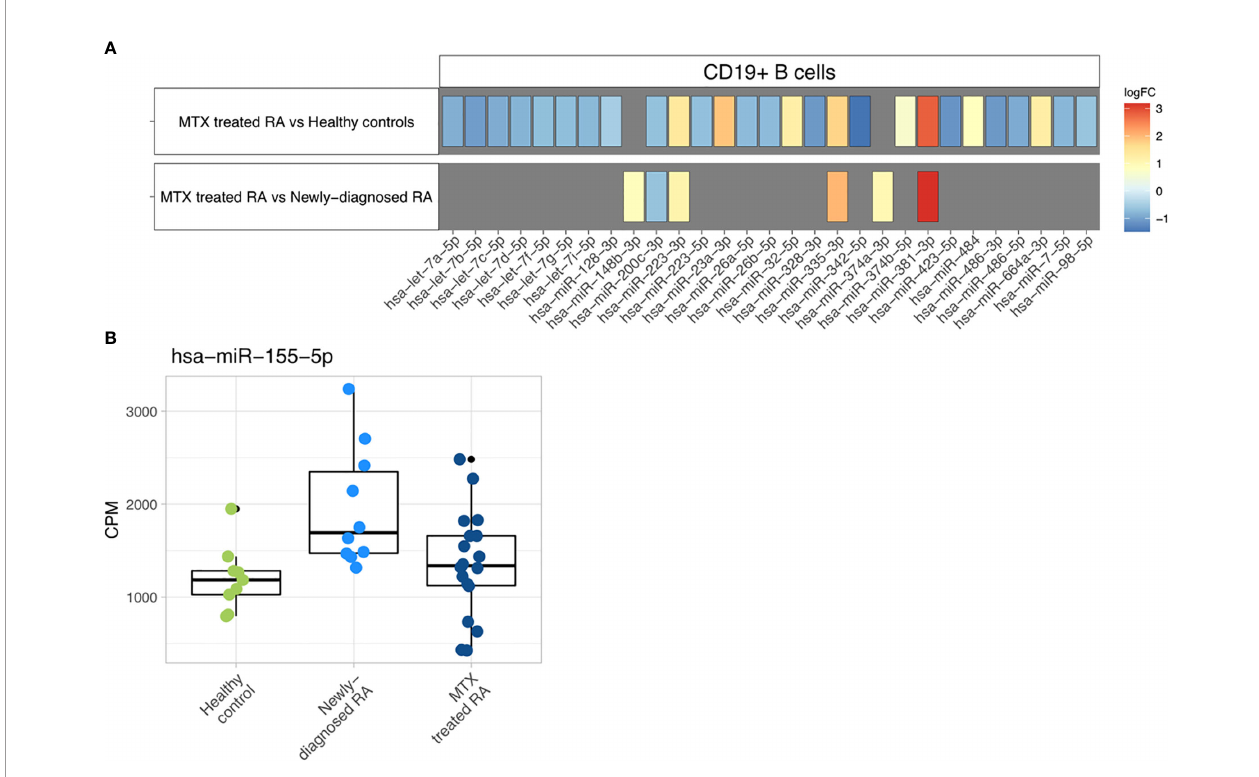
FIGURE 4 | Differential expression analysis. (A) Differentially expressed miRNAs are represented with their speci fi c log2 fold changes. (B) Boxplots representing the abundance of miR-155-5p in CPM based on study phenotype.